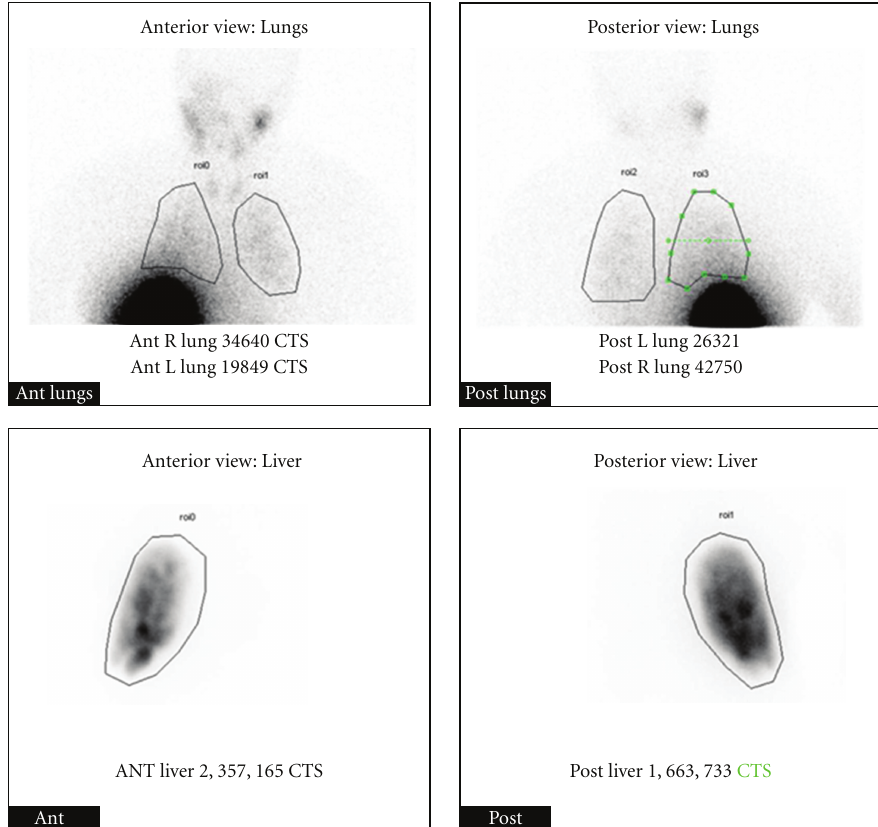
Figure 4: During the mapping angiogram phase, 5mCi of technetium-99m labeled macroaggregated albumin was injected within the right hepatic artery to quantify the liver-lung shunt. The planar scintigraphic images demonstrate distribution of the radiotracer within the right lobe of the liver without any abnormal extrahepatic distribution. Regions of interest were drawn within the lungs and liver resulting in an estimated maximum lung shunting of